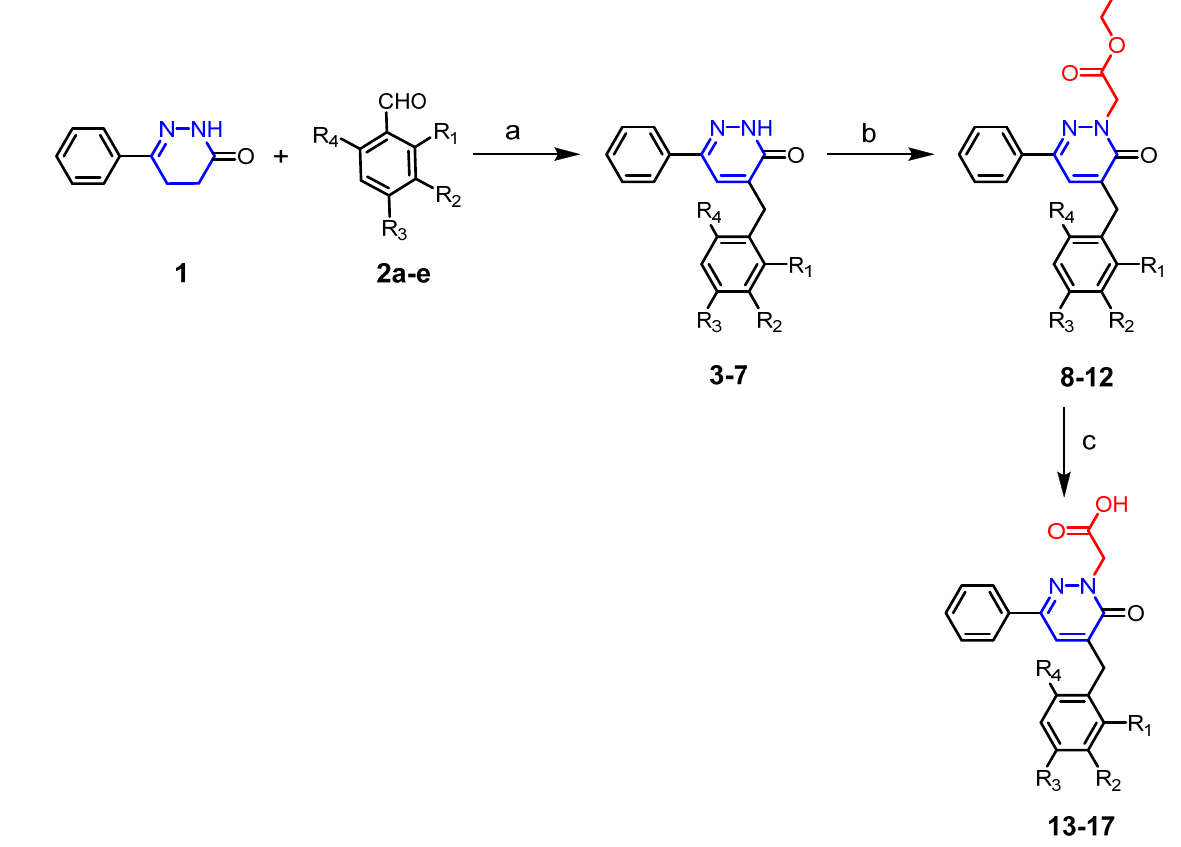
(Table 1) were obtained and the molecular structure were confirmed by FT-IR, 1 H NMR, 13